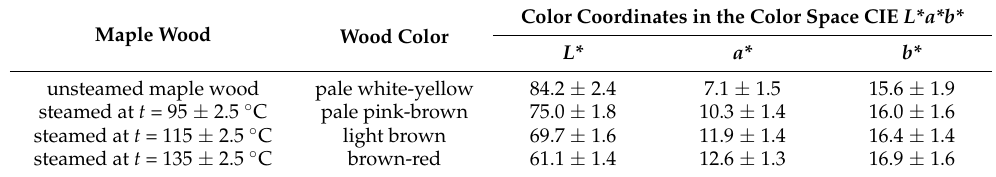
Table 1. Coordinate values of color space CIE L*a*b* of native and thermally treated maple